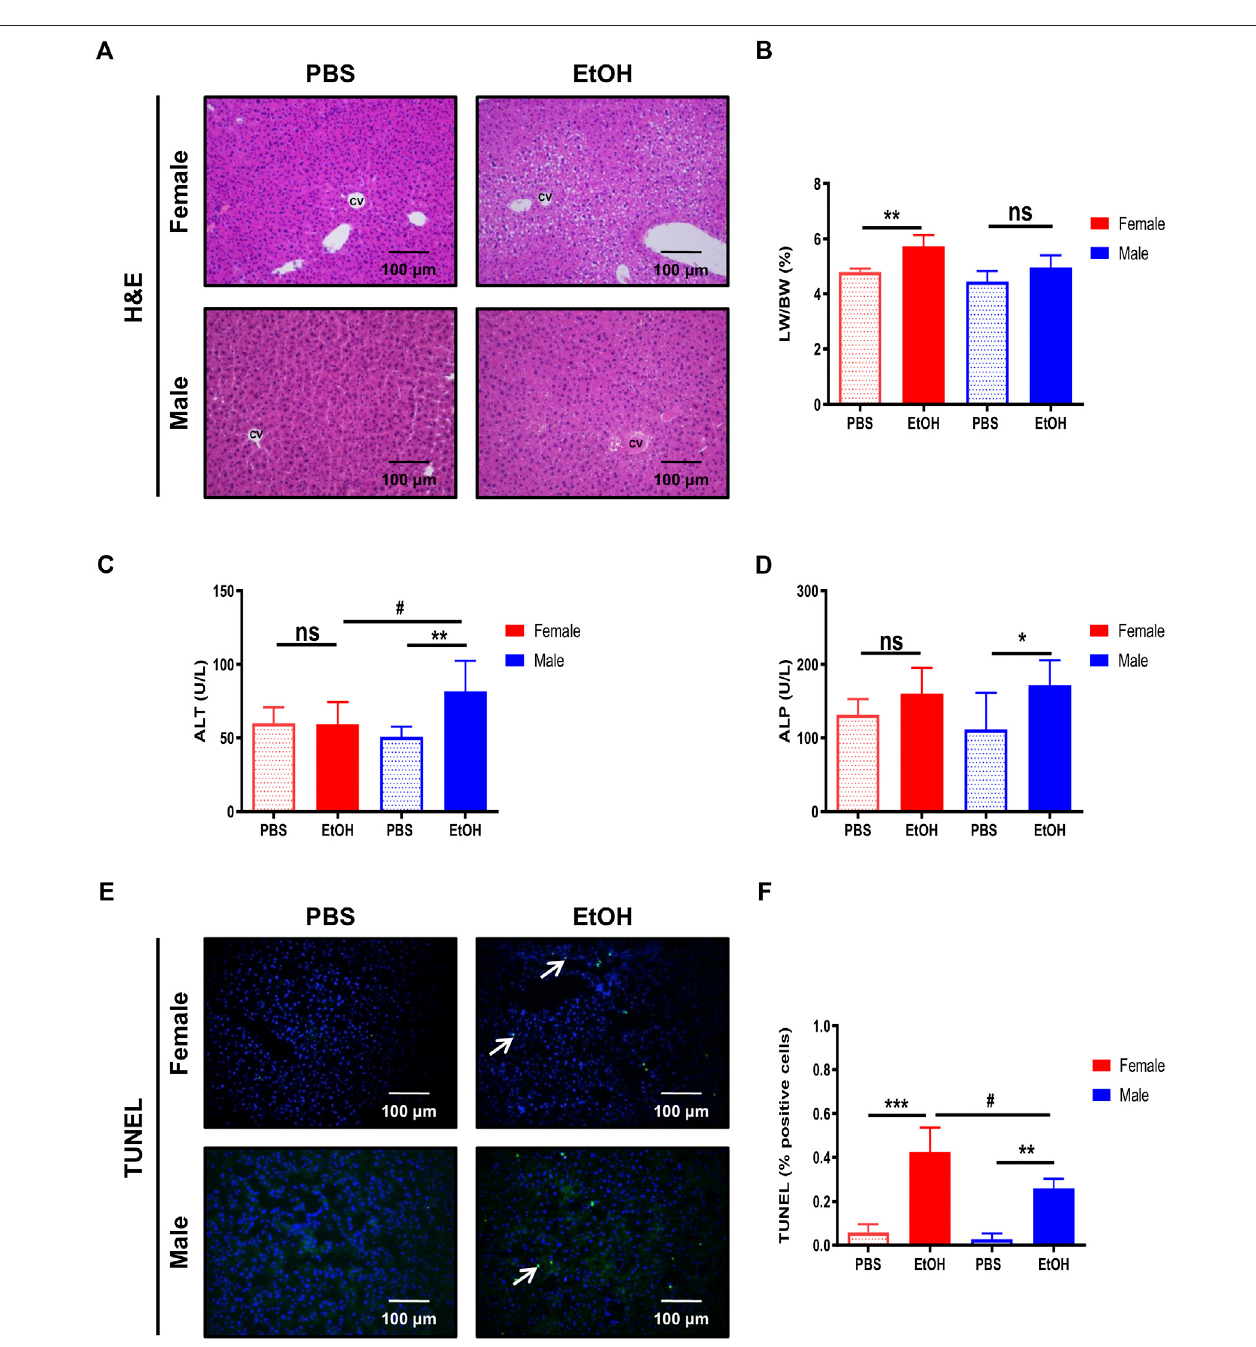
FIGURE2| Bingeethanolexposuretomicecauseschangesinliverarchitectureandcelldeath. (A) H&EstaininginfemaleandmalemicetreatedwithEtOH[6 g/kg] or PBS performed in paraf fi n liver sections ( n (cid:1) 6 – 8/group). (B) Liver-to-body weight (LW/BW) ratio in female and male mice after acute alcohol injury ( n (cid:1) 5 – 8/group). Serum (C) ALT and (D) ALP levels in female and male mice ( n (cid:1) 7 – 8/group). (E) TUNEL staining was performed in liver cryosections of female and male mice. (F) Quanti fi cation of TUNEL positive cells was done and graphed ( n (cid:1) 3/group;* p < 0.05, *** p < 0.001, # p < 0.05).